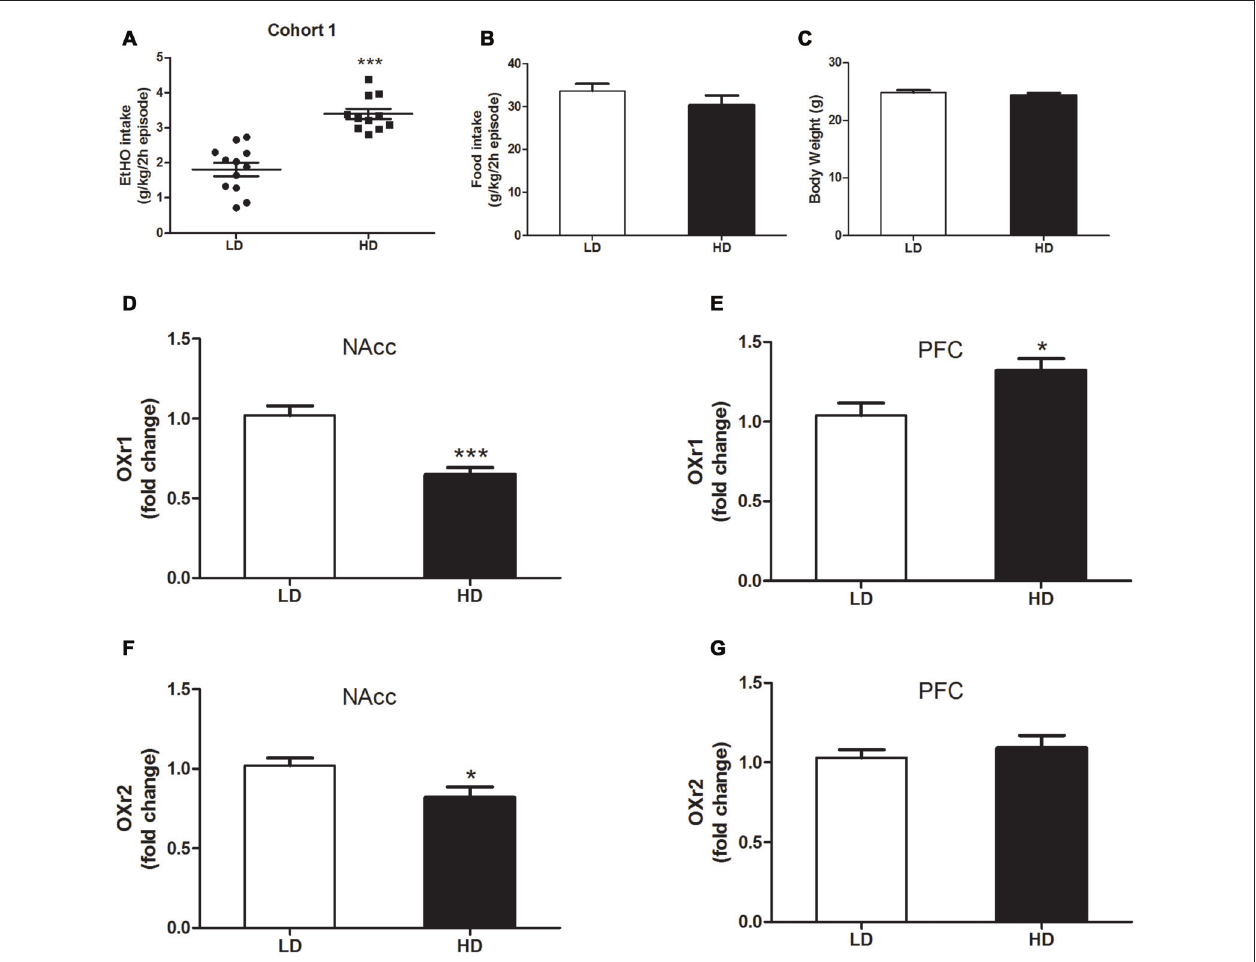
FIGURE 1 | Individual consumption of 20% (v/v) ethanol (EtOH) (A) , food intake (B) and body weight (BW) (C) during a single 2 h episode of drinking in the dark (DID), from which high drinkers (HD) and low drinkers (LD) subpopulations were identified [Cohort 1]. OX1r (D,E) and OX2r (F,G) mRNA expression within the NAcc and the prefrontal cortex (PFC) in HD vs. LD subpopulations. Brains were extracted after 10 days without EtOH after the DID test. All values are means ± SEM. ∗ p < 0.05 and ∗∗∗ p < 0.001.